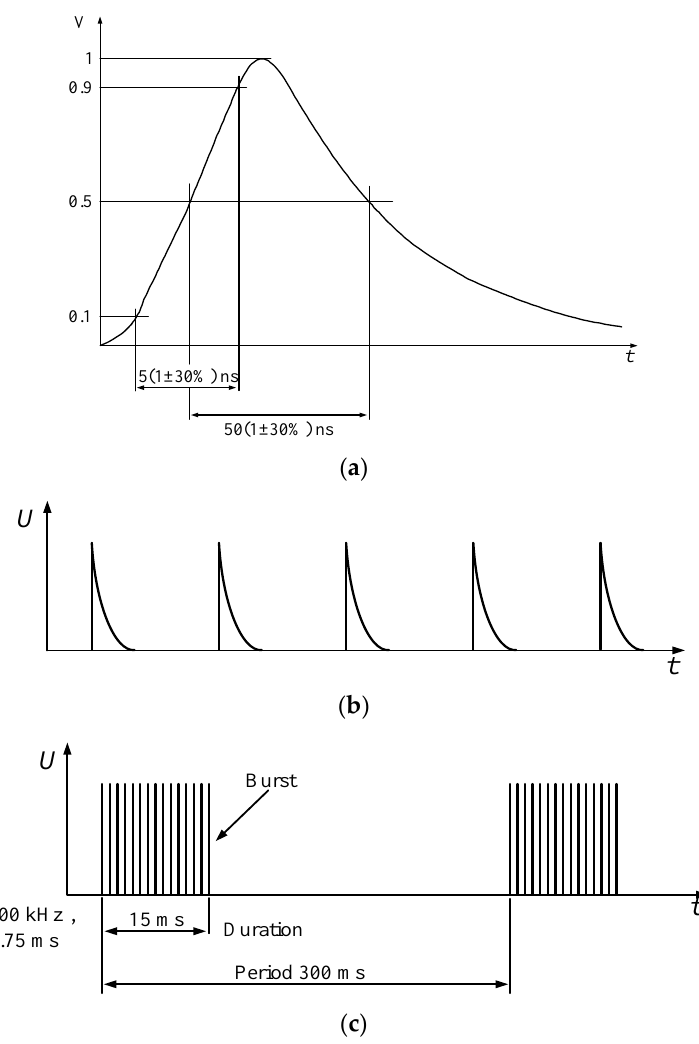
Figure 2. Traditional waveform of the electrical fast transient/burst (EFT/B) specified in IEC 61000-4-4: ( a ) Single pulse of the EFT/B. ( b ) A group of EFT/Bs. ( c ) Duration and period of the EFT/B.